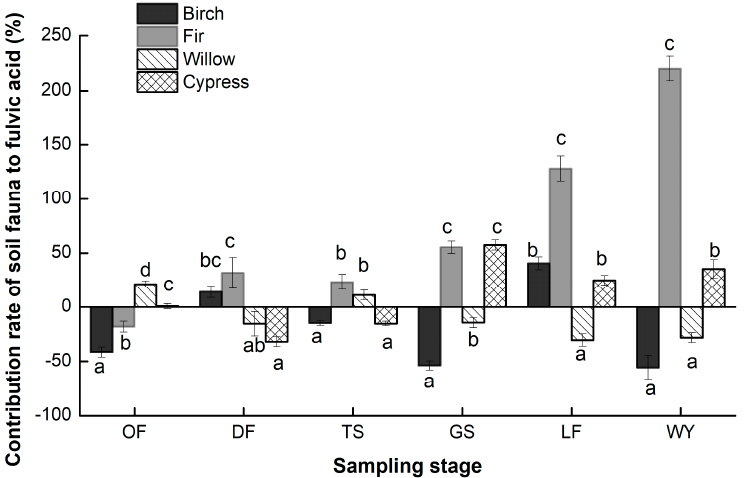
Figure 6. The contribution rate of soil fauna to the accumulation of four litter fulvic acid in different stages (mean ± standard error, n = 3). OF: onset of freezing stage, DF: deep freezing stage, TS: thawing stage, GS: growing season, LF: leaf falling stage, WY: whole year. The letters a–d mean in the sampling stage with different letters differ significantly, p <